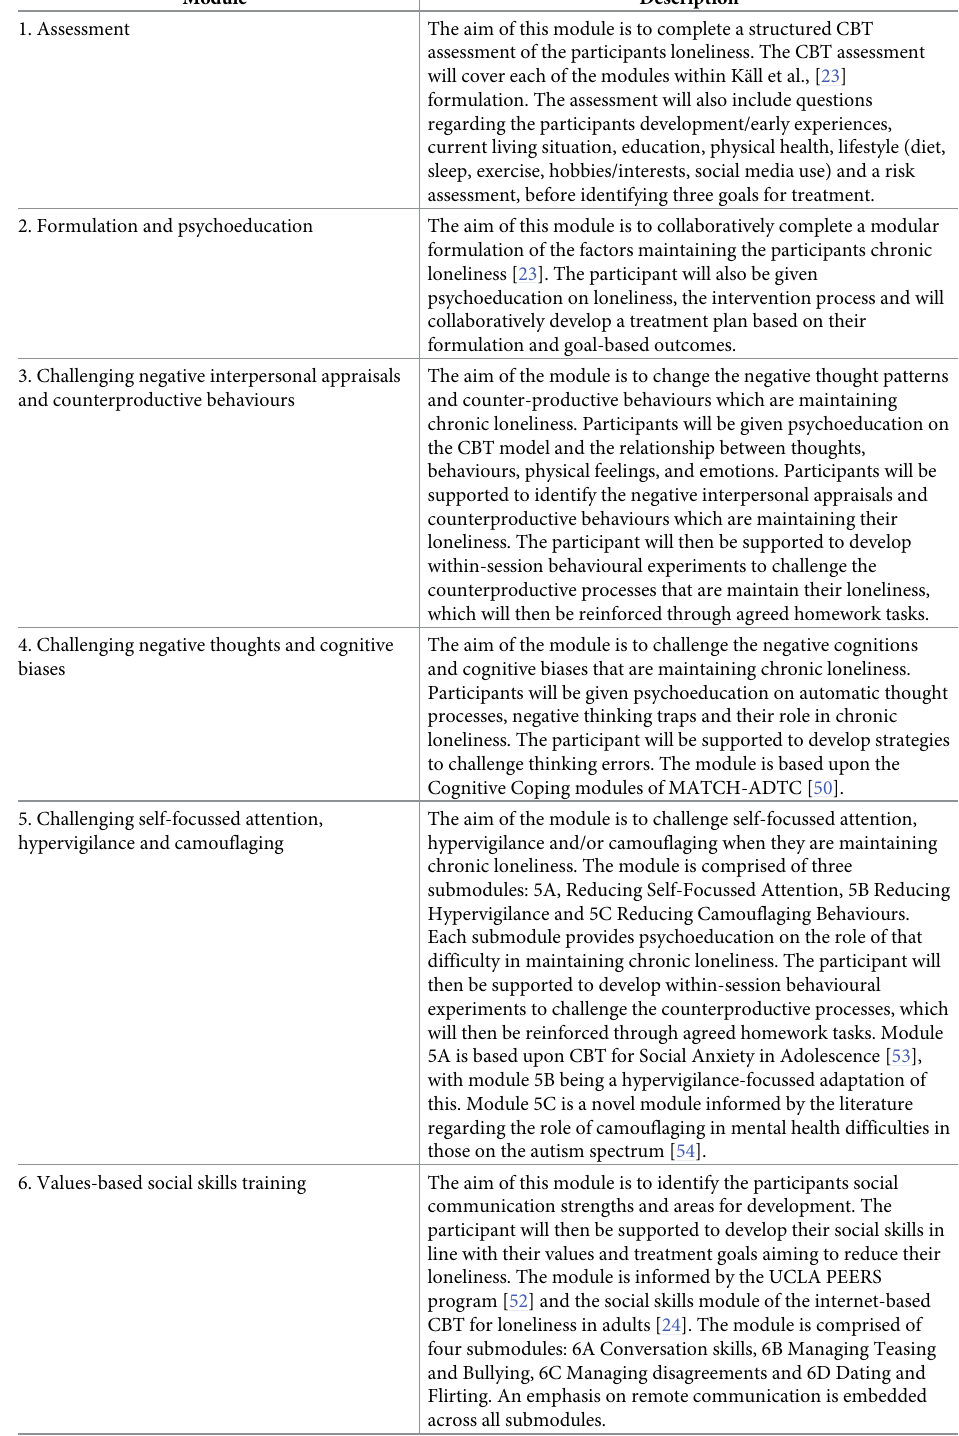
Table 1. Showing the treatment modules which comprise CBT for chronic loneliness in children and young